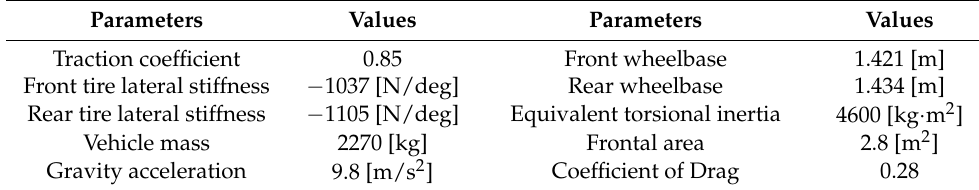
Table 2. The basic parameters of the vehicle